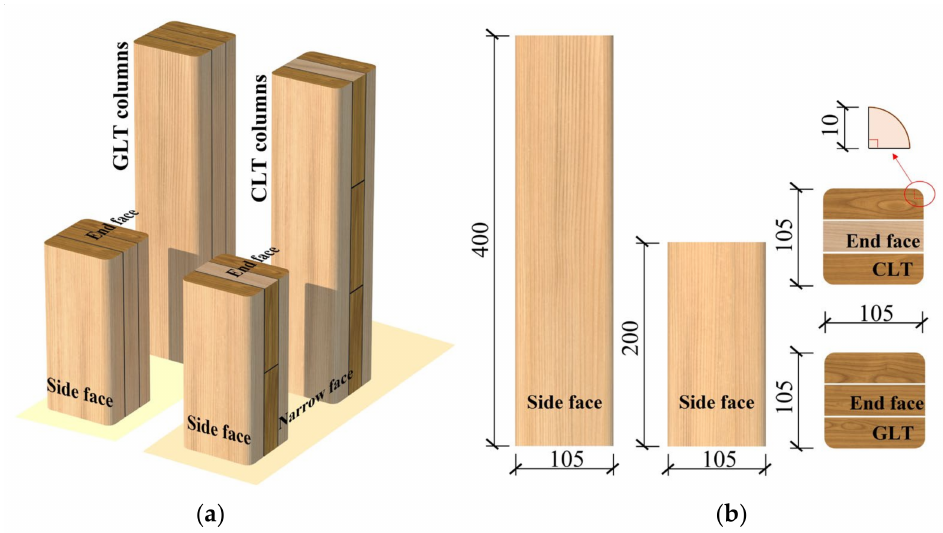
Figure 1. Diagram of GLT and CLT column specimens: ( a ) laminate combination; ( b ) dimensional parameters (dimensions in